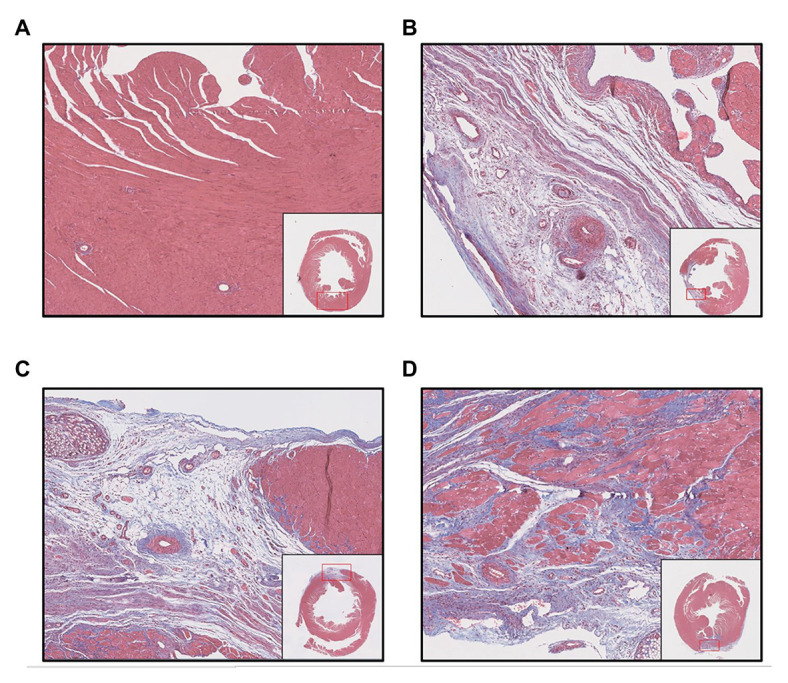
Left ventricular myocardial fibrosis (Masson staining 2 × 10 times). (A) Sham operation group; (B) control group; (C) sodium creatine phosphate group; and (D) Xinmailong group.